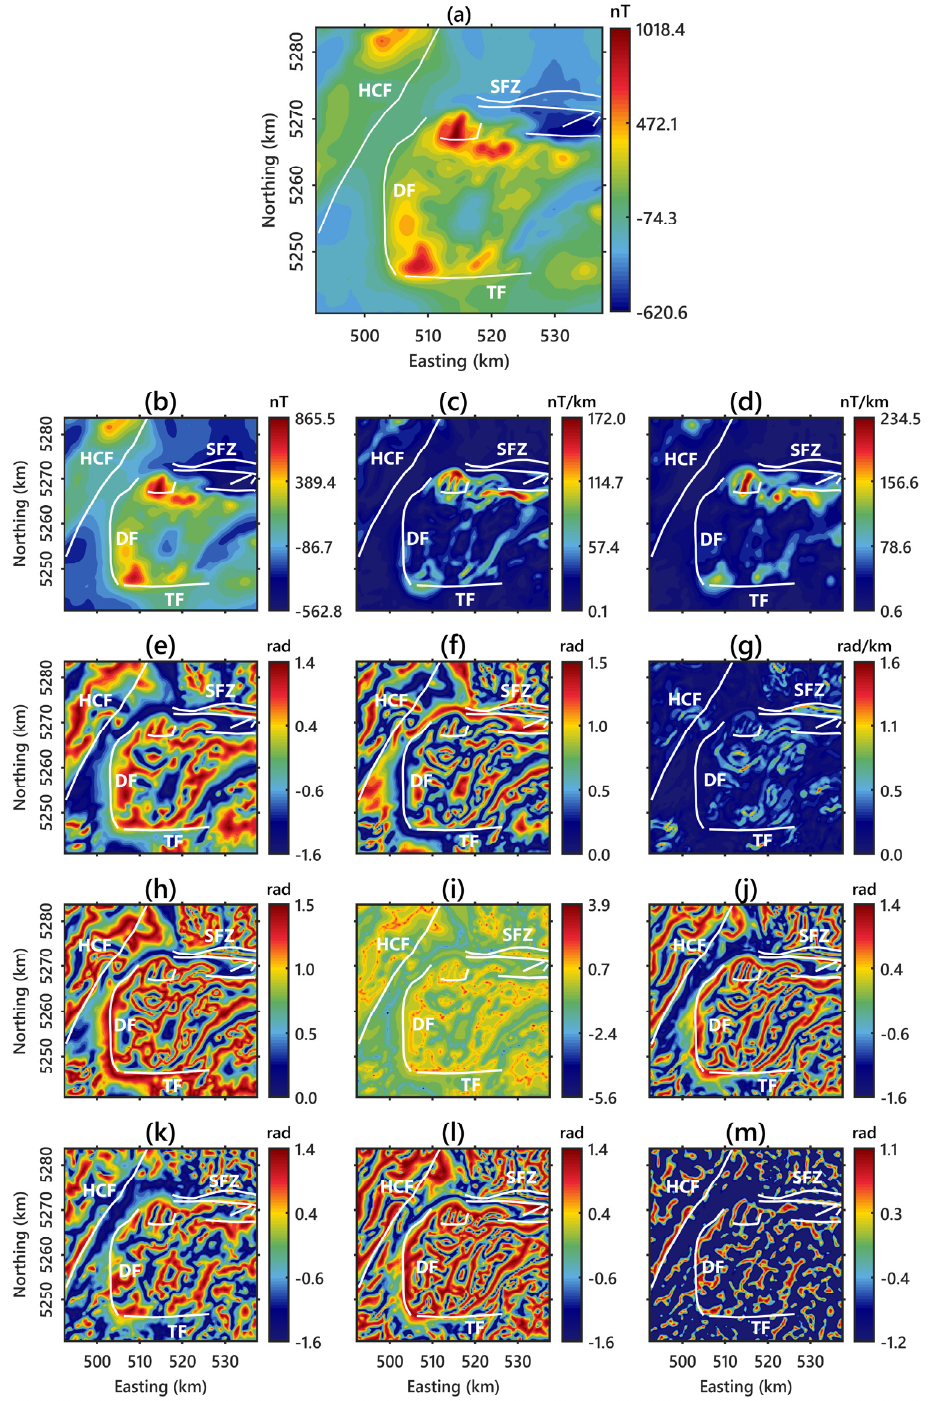
Figure 10. ( a ) The aeromagnetic anomaly map of the study region. The aeromagnetic anomaly map after continuing to 200 m upward is presented in ( b ). The response of various conventional edge detection filters namely ( c ) HG; ( d ) AS; ( e ) TA; ( f ) TM; ( g ) HGTA; ( h ) TDX; ( i ) HTA; ( j ) TAHG; ( k ) TAAS; ( l ) TBHG; and ( m ) ETG. The white lines over the response on all the figures show the true edge of the prisms.